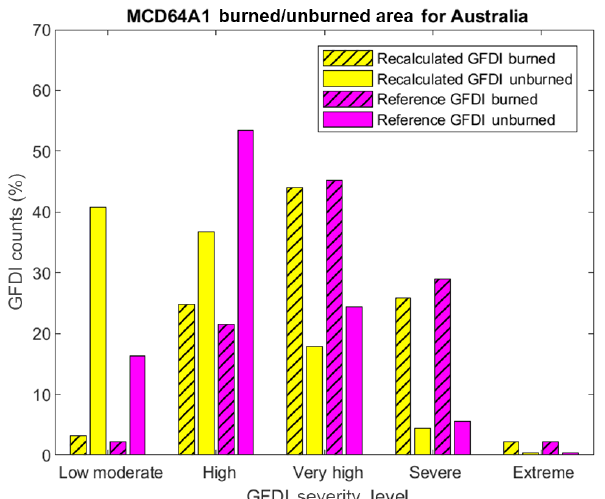
Figure 11. Grassland Fire Danger Index (GFDI) severity level histograms at burned and unburned areas over Australia during 4 July 2002 to 26 June 2011 where the dark and light blue shaded bars are recalculated GFDI with satellite estimated variable degree of curing (DOC), while the green and yellow shaded with diagonal hatch bars are reference GFDI with constant DOC at